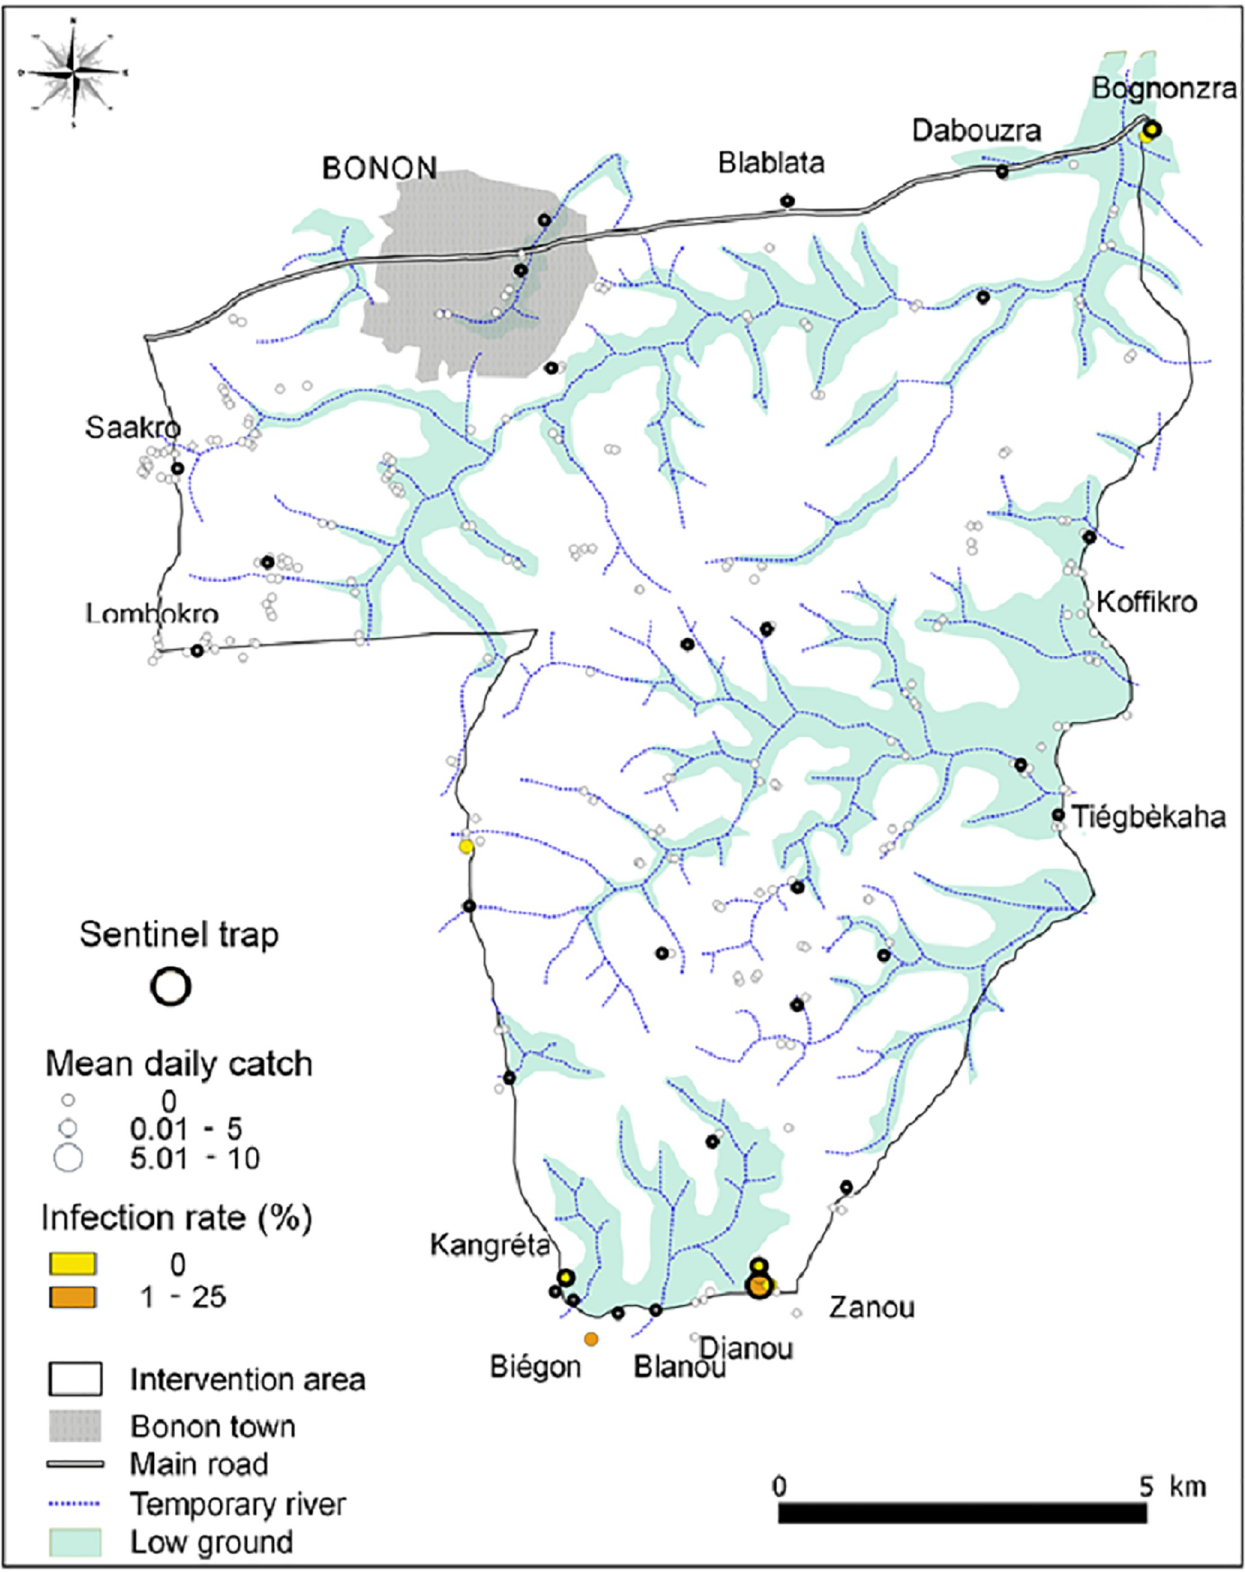
Fig 8. Numbers and infection rates of tsetse caught during the T11 entomological survey conducted in December 2018. https://doi.org/10.1371/journal.pntd.0009404.g008 PLOS NeglectedTropical Diseases | https://doi.org/10.1371/journal.pntd.0009404 June 28,